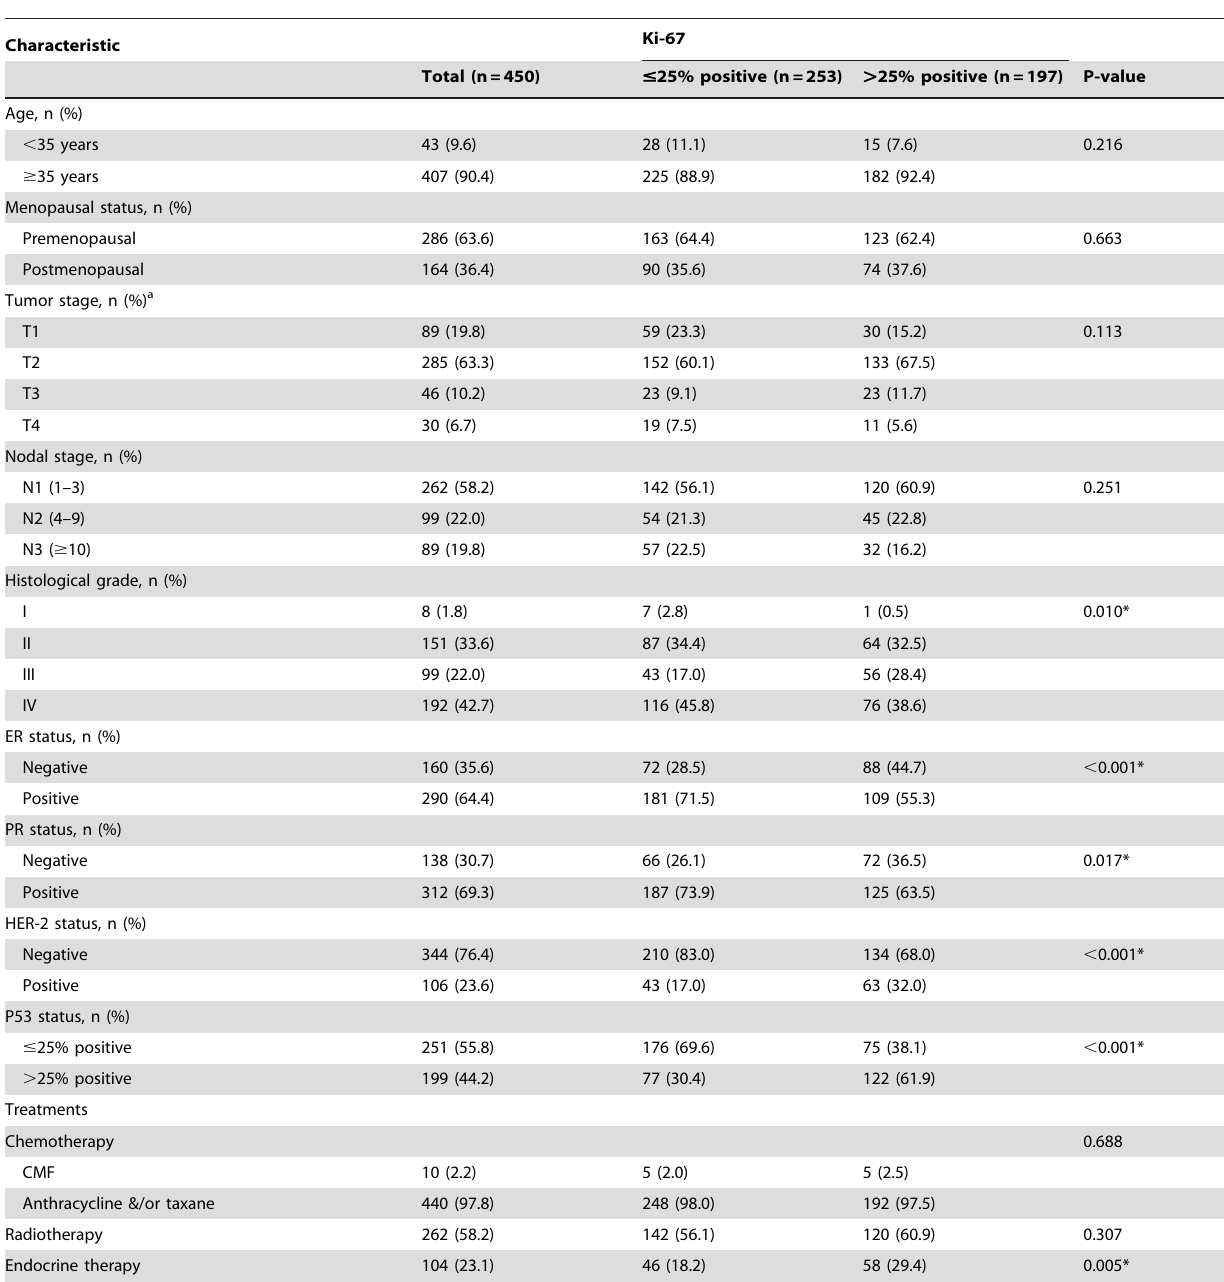
Table 1. The clinicopathologic characteristics of entire cohort and association between Ki-67 and clinicopathologic characteristics.